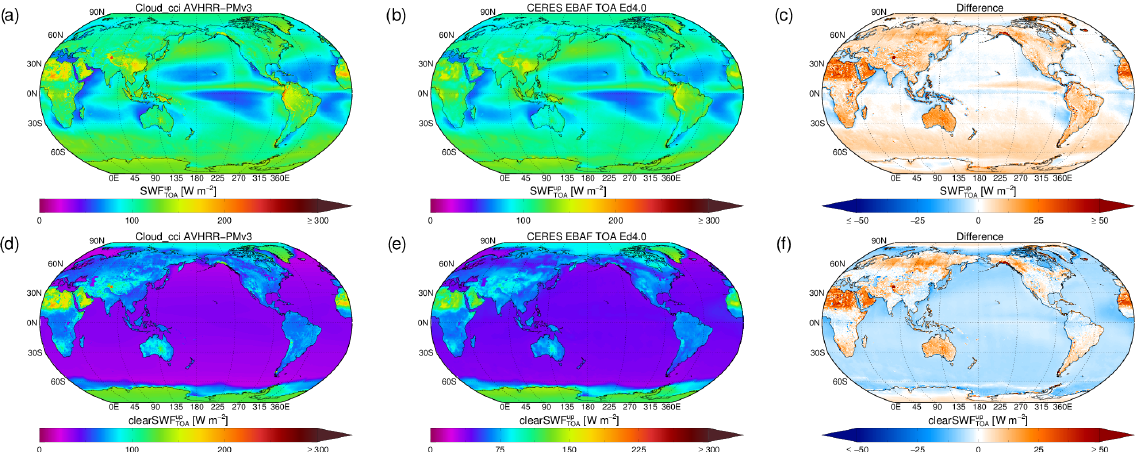
Figure 8. Multi-annual (2003–2016) mean top-of-atmosphere (TOA) upwelling shortwave (SW) radiative fluxes for all-sky conditions for Cloud_cci AVHRR-PMv3 (a) and CERES EBAF TOA Edition 4.0 (b) . Panels (d) and (e) show the same data but for clear-sky conditions. Panels (c) and (f) show difference plots Cloud_cci minus CERES.